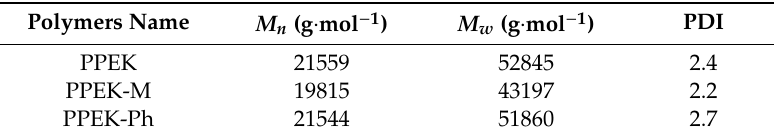
Table 1. The molecular masses of the PPEKs resins